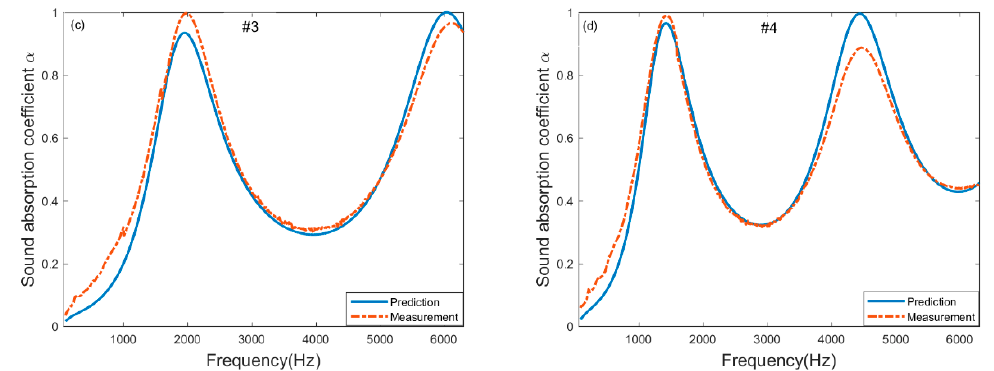
Figure 6. Comparison between measurement and prediction for the samples listed in using the inversion parameters estimated in (a) new sample #1 ; (b) new sample #2; (c) new sample #3 ; (d) new sample #4.